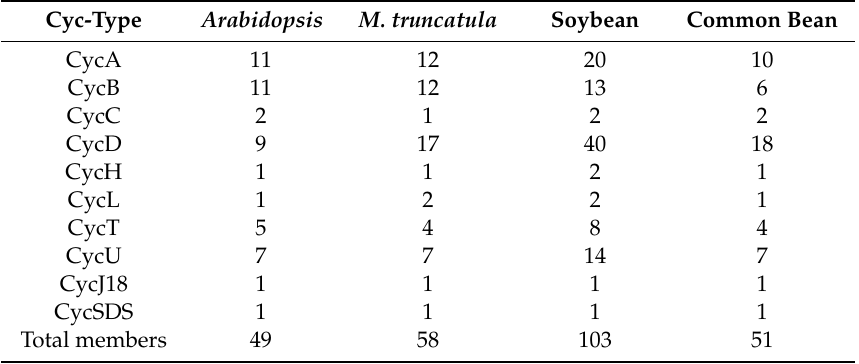
Table 1. Cyclins’ content in Arabidopsis , M. truncatula , soybean and common